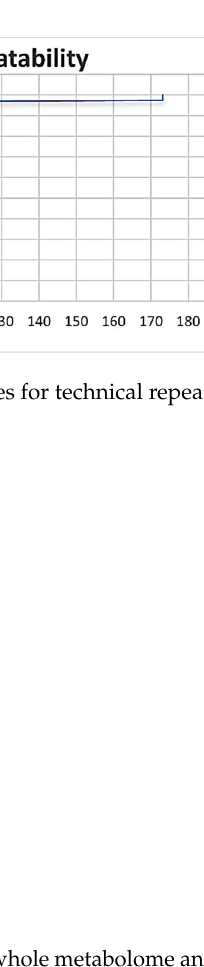
Figure 2. PCA scores plot obtained from GCxGC-TOFMS whole metabolome analysis of Mtb samples in the presence and absence of ciprofloxacin. The variances accounted for are indicated in parentheses.